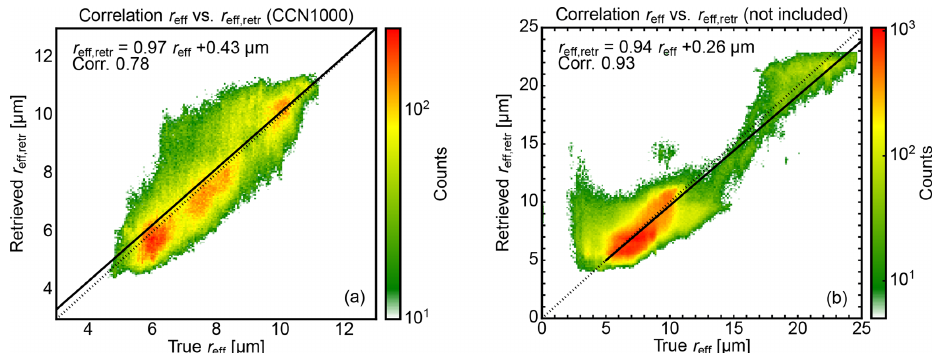
Figure 22. Two-dimensional histograms and linear regressions to determine the correlation between the apparent effective radius r eff and the retrieved effective radius r eff , retr for (a) the included polluted cases ( N CCN = 100cm − 3 ) with normal and flipped effective radius profile, and (b) for the not included cases with normal and flipped effective radius profile. Table 2. Results of retrieval performance tests when faced with normal, flipped, and not included effective radius profiles, grouped for CCN = 1000, CCN = 100, and for all not included cases. Linear regression, bias, root-mean-square error (RMSE), and correlation are calculated between apparent and retrieved effective radius.